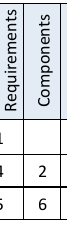
Figure 1. Multi-domain matrix